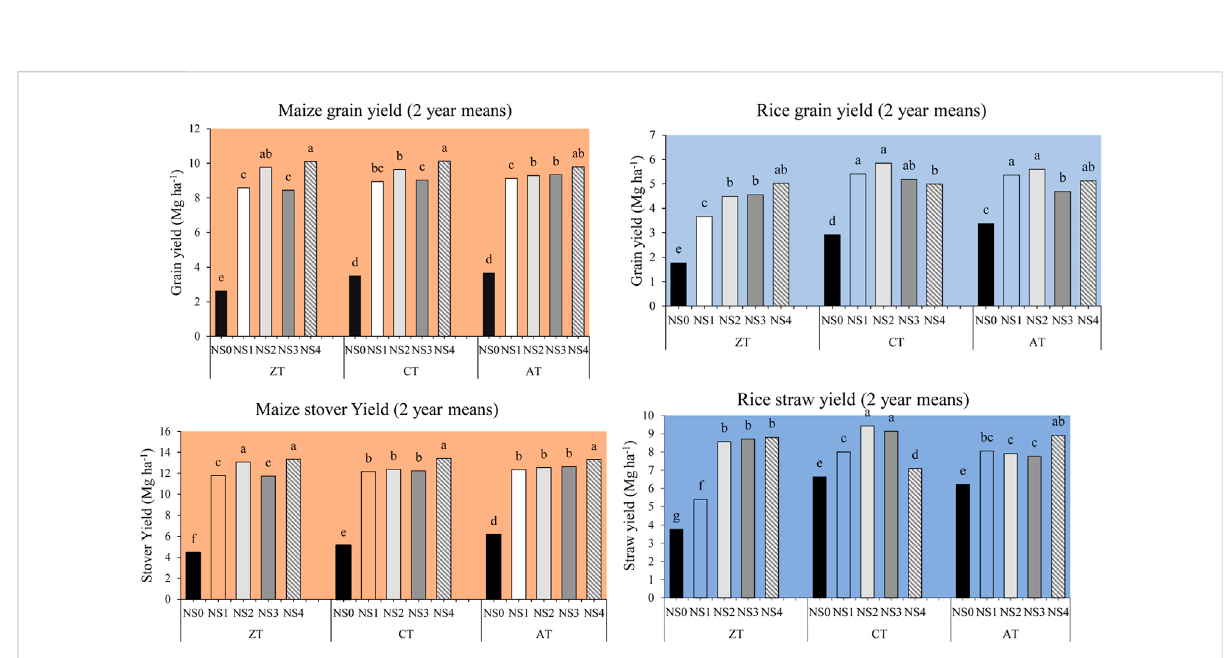
FIGURE 3 Mean yields for maize grain and stover & rice grain and straw over a 2-year cropping sequence. Same letters above the bars indicate no signi fi cant difference acrossthetreatment combinationsas tested byFisher ’ sLSDcomparisonofmeans( α =0.05). ZT,zero tillage;CT, conventional tillage; AT, alternate tillage (maize: zero and rice: conventional tillage), NS 0 = no nitrogen (control, 0:50:100), NS 1 = recommended dose of NPK fertilizer (N 160 P 50 K 100 ),NS 2 =NS 1 +cropresidueat6 Mg/ha, NS 3 =75% ofrecommendedNas fertilizeralongwith25%NasFYM(N 120 P 50 K 100 + FYM at 40 kg · N/ha), NS 4 = 75% of recommended N as fertilizer along with at 25% N as vermicompost (N 120 P 50 K 100 + VM at 40 kg ·